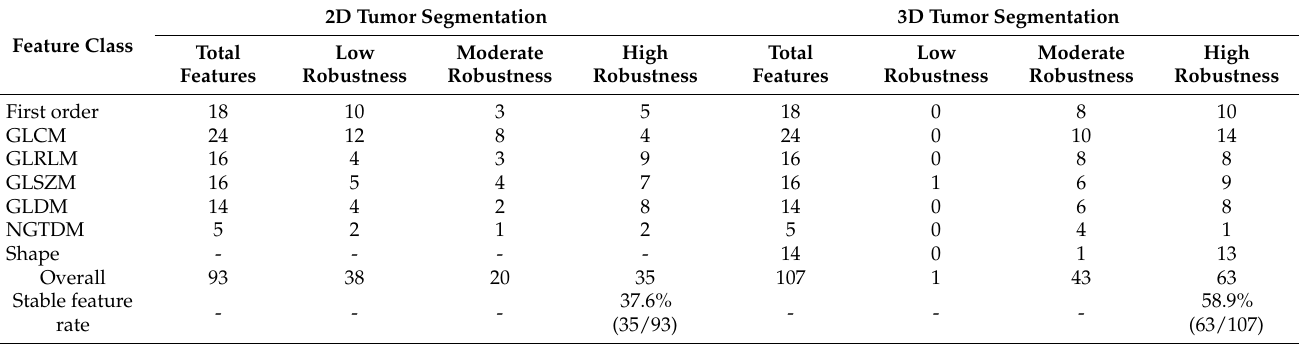
Table 3. Inter-observer variability of the radiomic-features family and stable feature rate for 2D and 3D tumor segmentations.